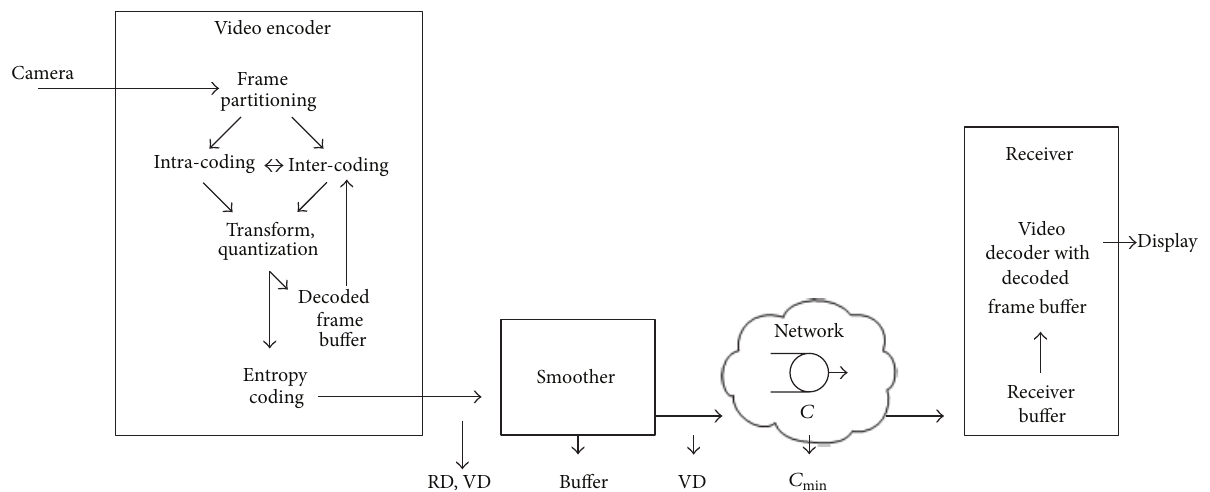
Figure 1: Block diagram of video network transport system. The captured video frames are encoded and smoothed before network transmission. The evaluations of video transmission consider the rate-distortion (RD) characteristics, the rate variability-distortion (VD) characteristics before and after the smoother, and the required smoother buffer and the link bitrate 𝐶 min